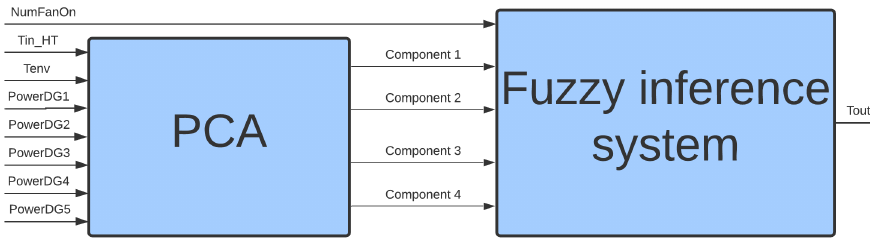
Figure 8. Digital twins input-output after dimensionality reduction.